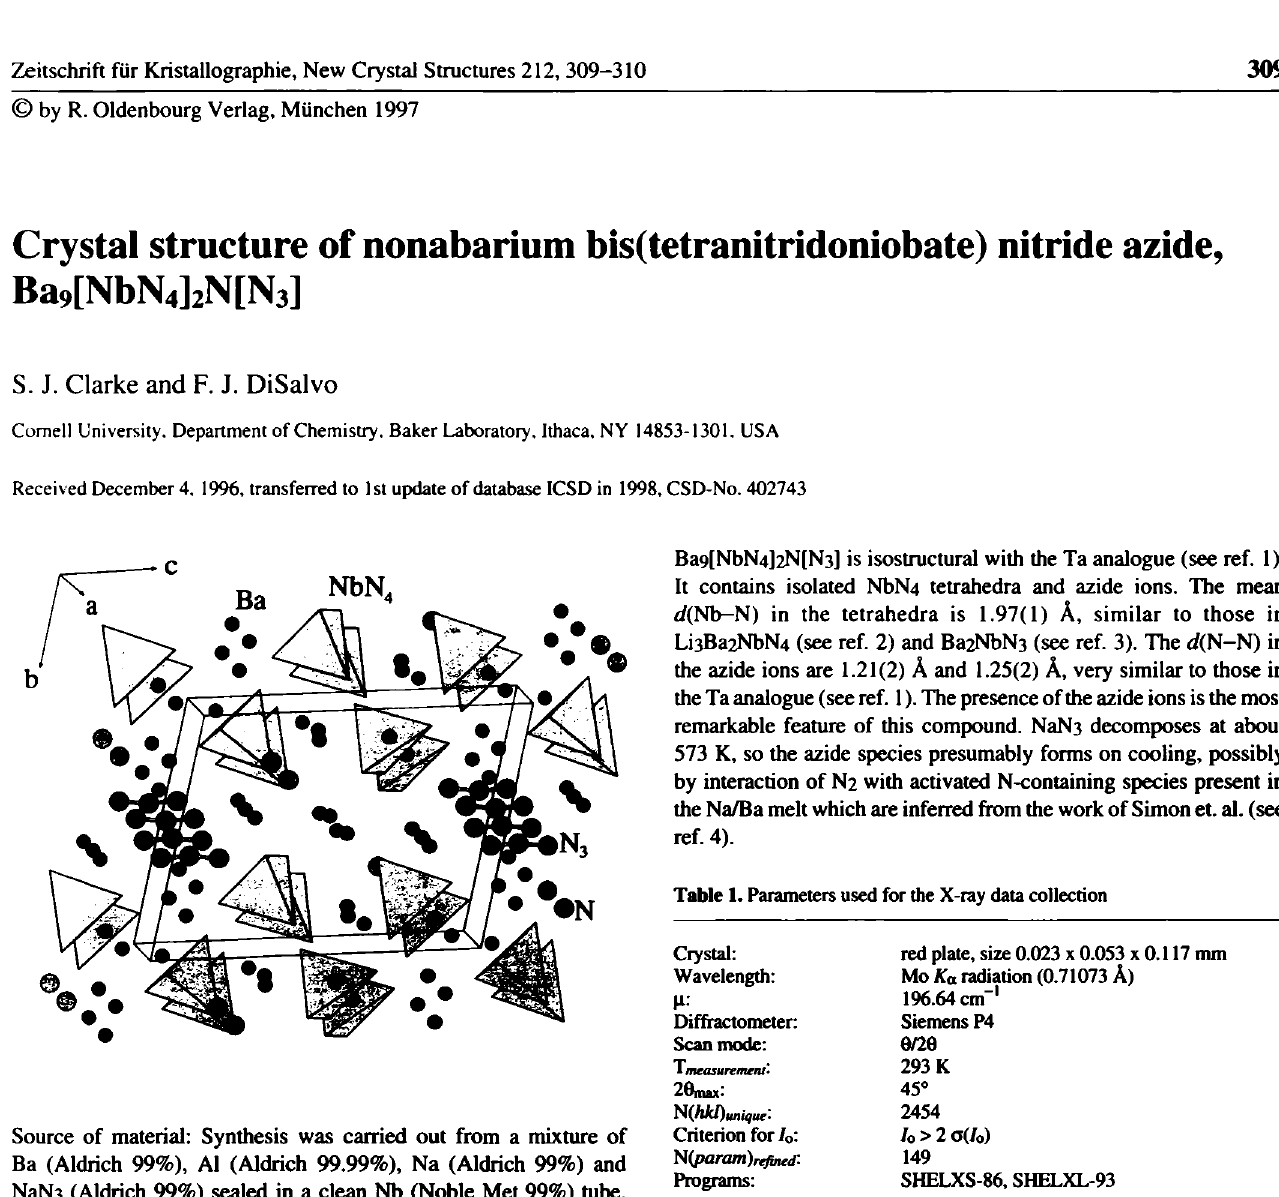
Table 2. Final atomic coordinates and displacement parameters (in Â 2 )